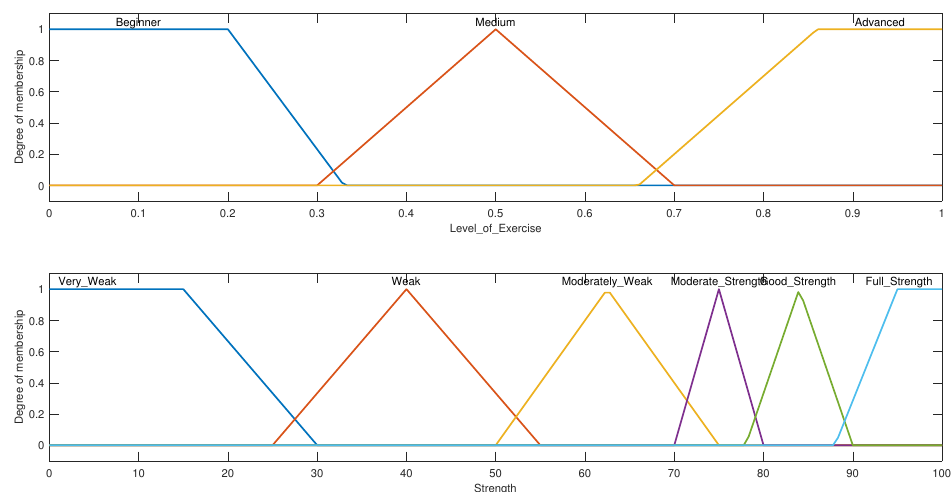
Figure 6. The input membership functions for strength/stretch FIS.